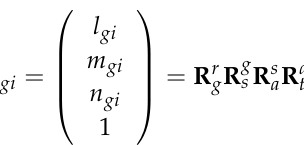
Figure 5. Coordinate transformation process.